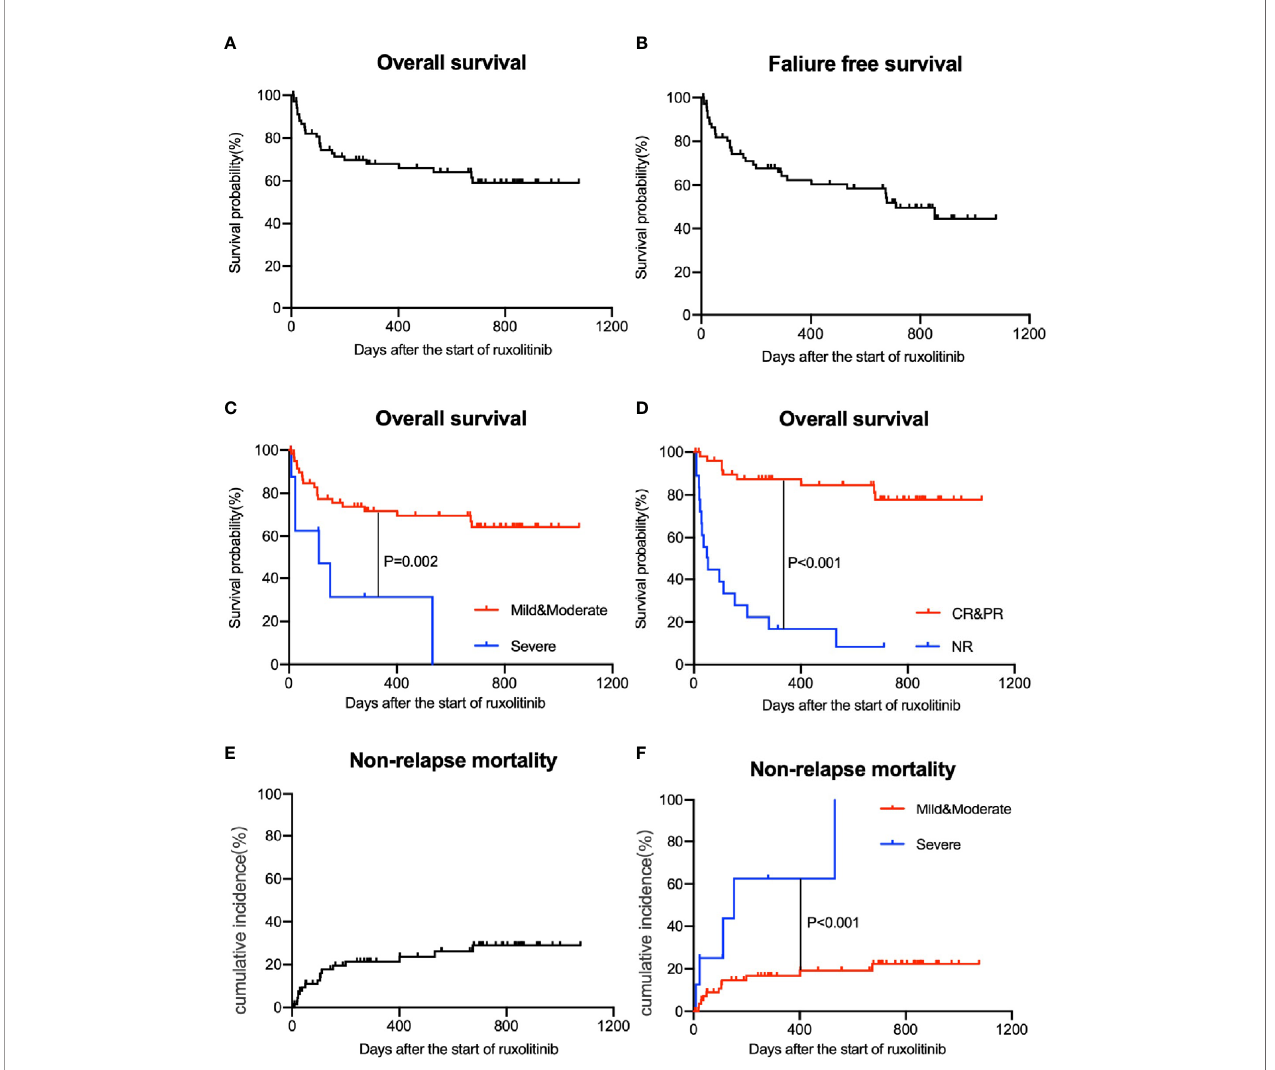
FIGURE 3 | Overall survival (OS) and nonrelapse mortality (NRM) of patients with cGVHD. (A) OS of all patients. (B) Failure-free survival (FFS) of all patients. (C) Comparisons of OS among different grade groups. (D) Comparisons of OS among different treatment ef fi cacy groups. (E) NRM of all patients. (F) Comparisons of NRM among different grade